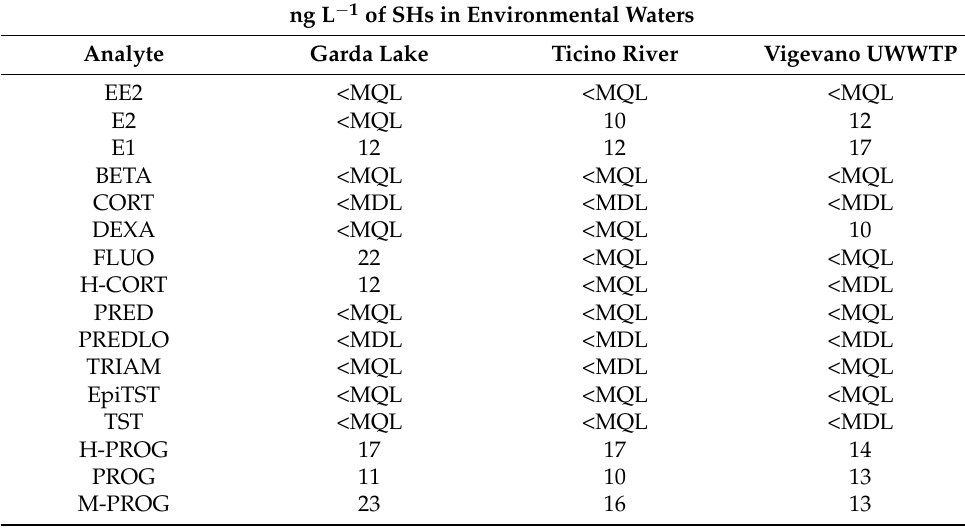
Table 4. Nanograms per liter of SHs quantified in Garda Lake, Ticino River, and Vigevano UWWTP effluent water